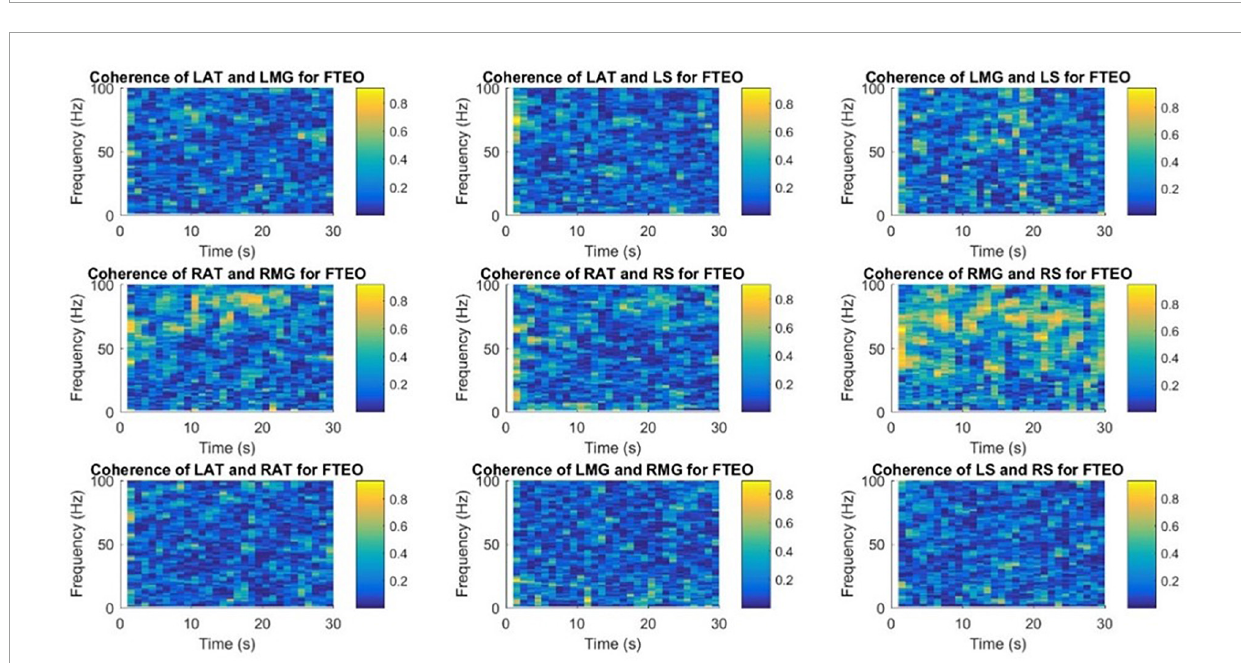
FIGURE9 Time-frequency coherence spectrogram of different muscle pairs under FTEO condition for a single participant for a single trial. The figure represents EMG-EMG coherence of different muscle pairs for a particular frequency and time with blue representing the lowest intermuscular coherence and yellow representing higher coherence between muscle pairs under the most stable postural standing position.